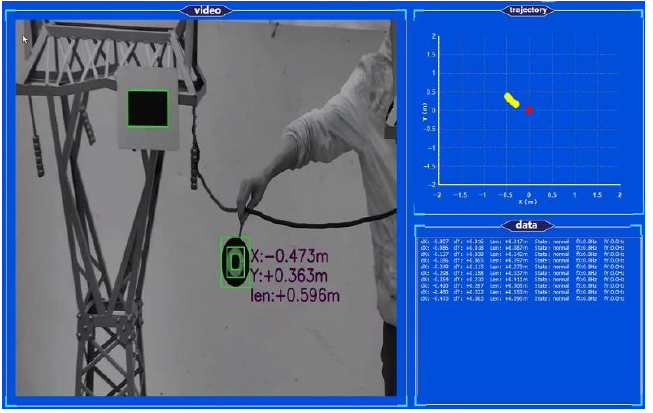
Figure 6. The galloping accuracy testing method.